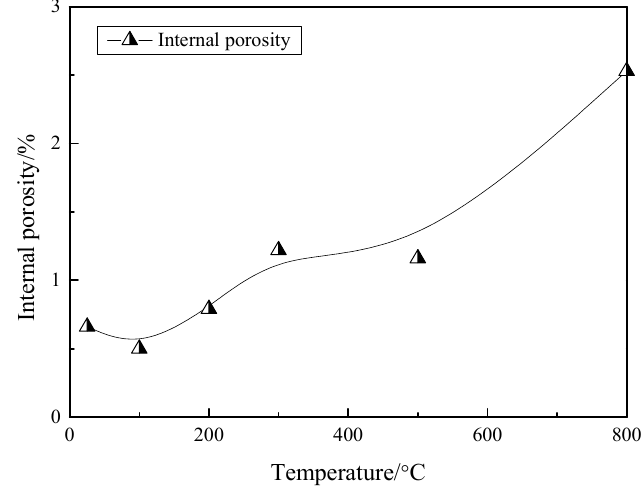
Figure 4. Variations of internal porosity of granites with temperature.